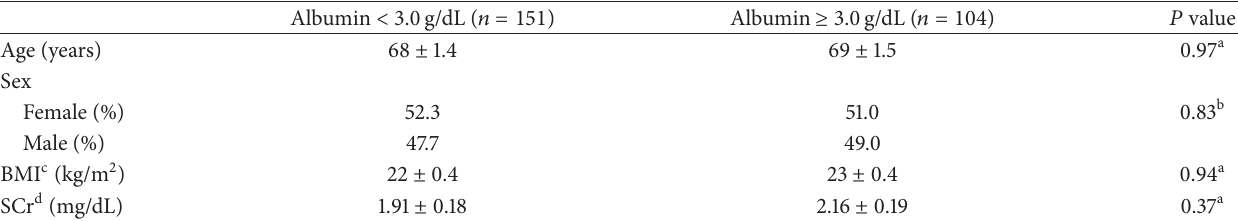
Table 1: Demographic